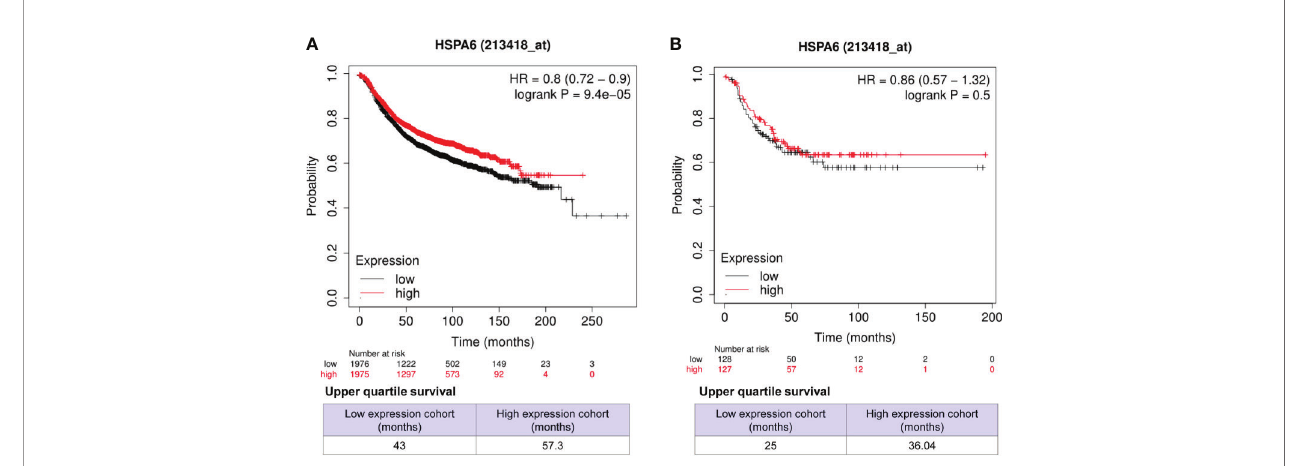
FIGURE 7 | High expression of HSPA6 is correlated with long overall survival for breast cancer patients in clinic. (A) All subtypes of breast cancer patients. (B) TNBC patients. The breast cancer patient samples are split into two groups according to the indicated upper quantile expressions of HSPA6 from dataset of 213418_at. The HR with 95% con fi dence intervals and logrank p value were calculated. The logrank p value <=0.5 was set as a difference and logrank p value <=0.01 was set as a signi fi cant difference. HR, hazard